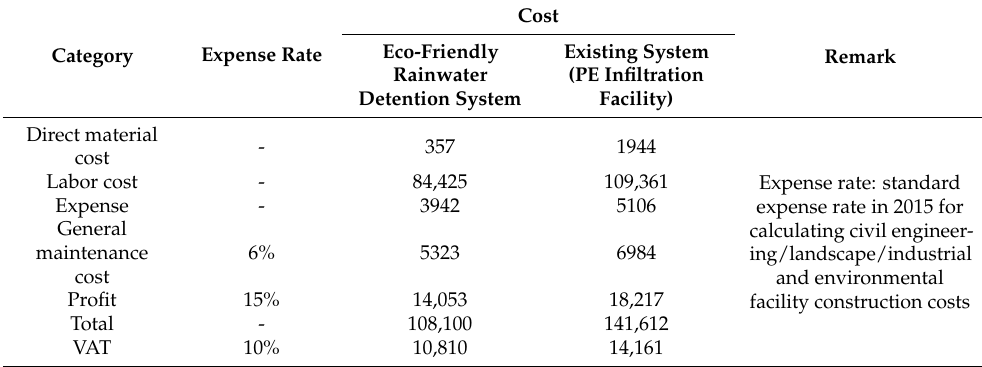
Table 15. Sediment removal cost